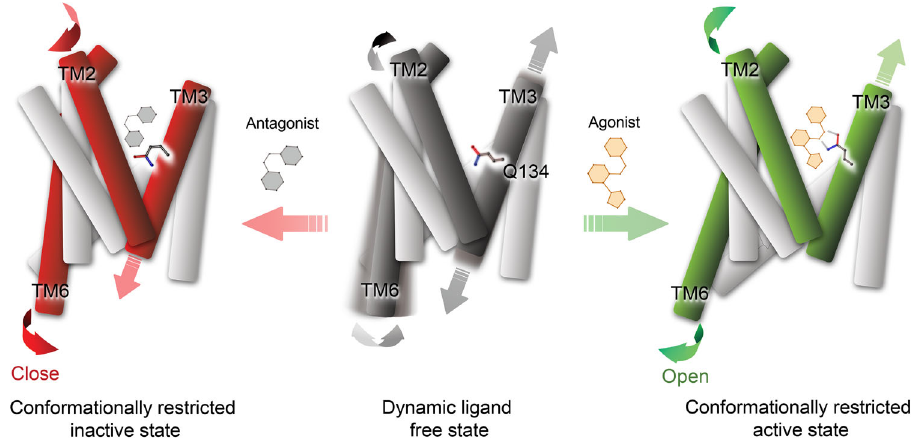
Fig. 6 Mechanism of OX 2 R activation and inactivation. Schematic representation of OX 2 R in ligand-free (middle), antagonist-bound (left), and agonist- bound (right) states. The sidechain of mechanistically important Q134 3.32 is shown in stick representation. Conformational fl exibility in TM2, TM3, and TM6 in the ligand-free state is indicated with gray arrows, while conformational changes upon agonist and antagonist binding are highlighted by green and red arrows,